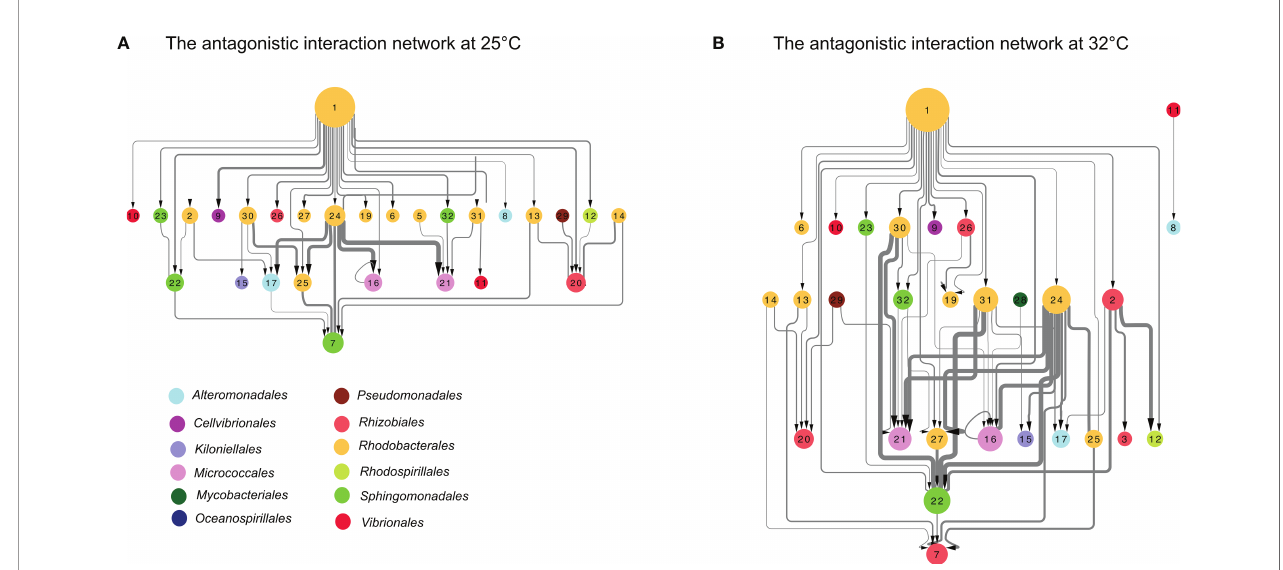
FIGURE 3 | The antagonistic interaction network included antagonistic pairs and intensity at 25°C (A) and 32°C (B) . The “ edges ” depict directed inhibitory interactions, and the “ nodes ” represent strains. The size of the “ edges ” shows the intensity of the interactions. The size of the “ nodes ” represents the total number of degrees, including sender degrees and receiver degrees. The code of each isolate was included in Table S1 . Colors of the nodes represent the taxonomic information of isolates at the order level.